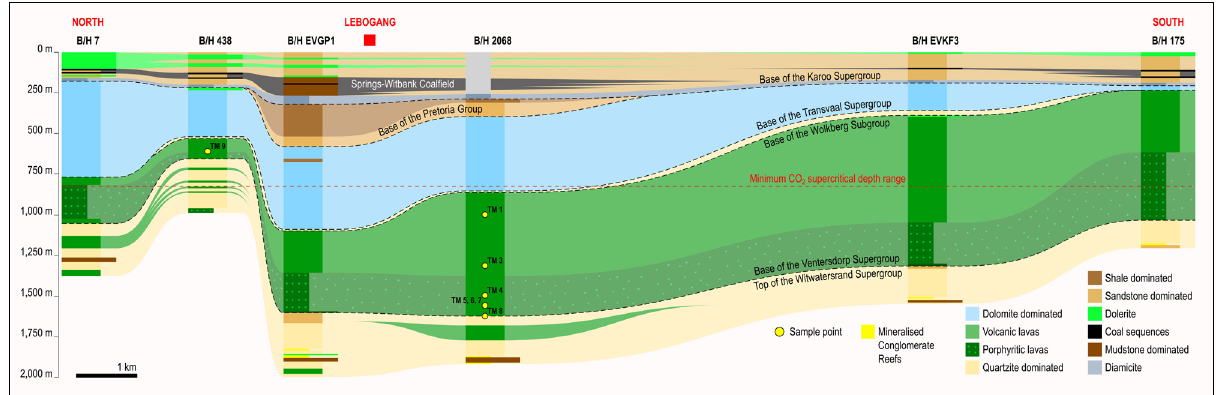
emitters, as shown in Figure 2. Data from the 2